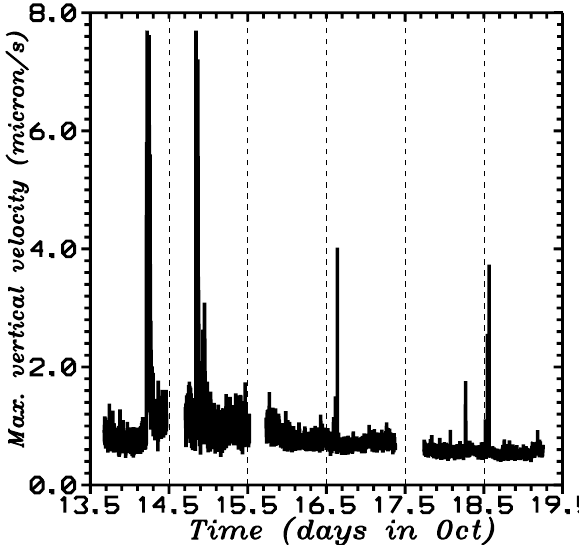
FIG. 11. Maximum ground velocity in the TARP